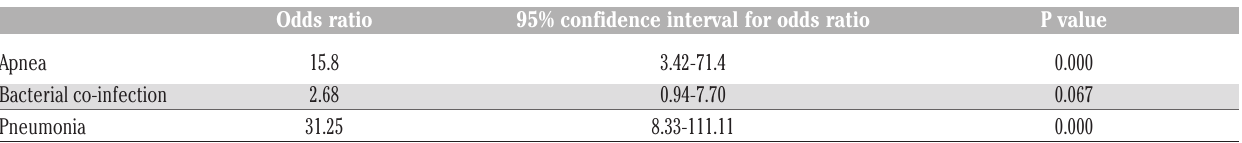
Table 4. Multivariate analysis regression for risk factors.